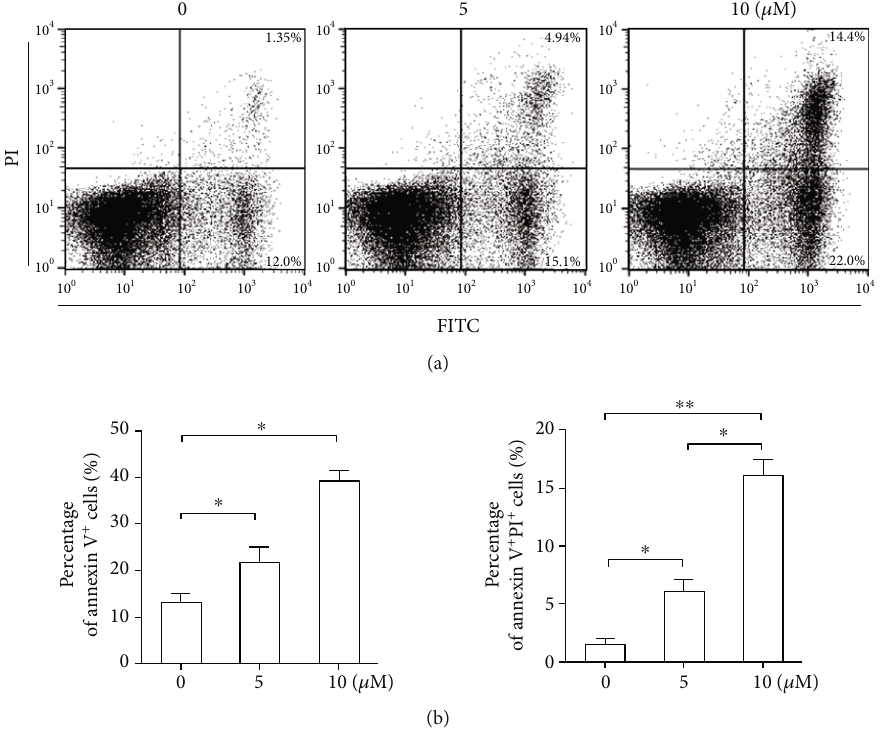
Figure 4: LY2109761 promotes keloid-derived fi broblast apoptosis. Annexin V-FITC/PI staining was followed by treatment with increasing doses of LY2109761. (a) Representative scatter plot images. (b) Summarized results are shown as the mean ± SEM from three independent experiments. ∗ P < 0 : 05 between LY2109761 groups and DMSO control; ∗∗ P < 0 : 05 between LY2109761 5 μ M and 10 μ M treatment